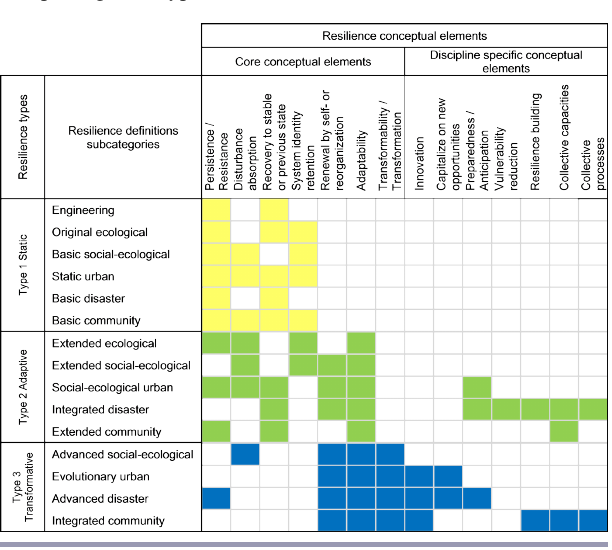
Fig. 2 . Typology of ideal resilience interpretations showing